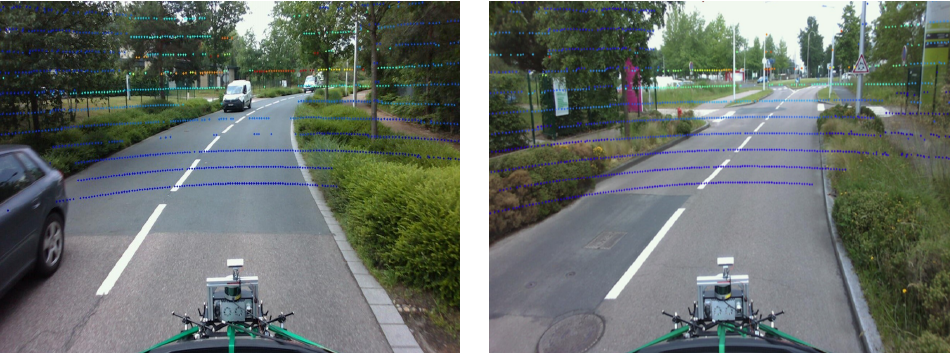
Figure 9. Results of the projection of LiDAR points on the dynamic image. The coloring is related to the distance (depth) of the point from the